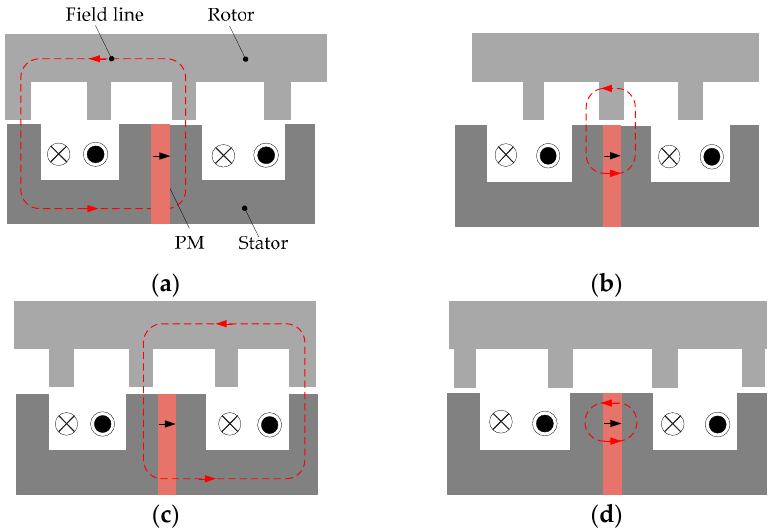
Figure 2. Working principle of PMFS type at four typical positions: ( a ) Positon 1; ( b ) Position 2; ( c ) Position 3; ( d ) Position 4.